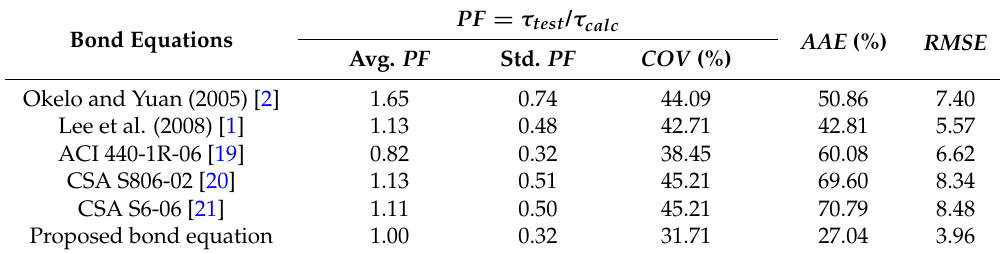
Table 6. Comparison of bond equations for the fourth